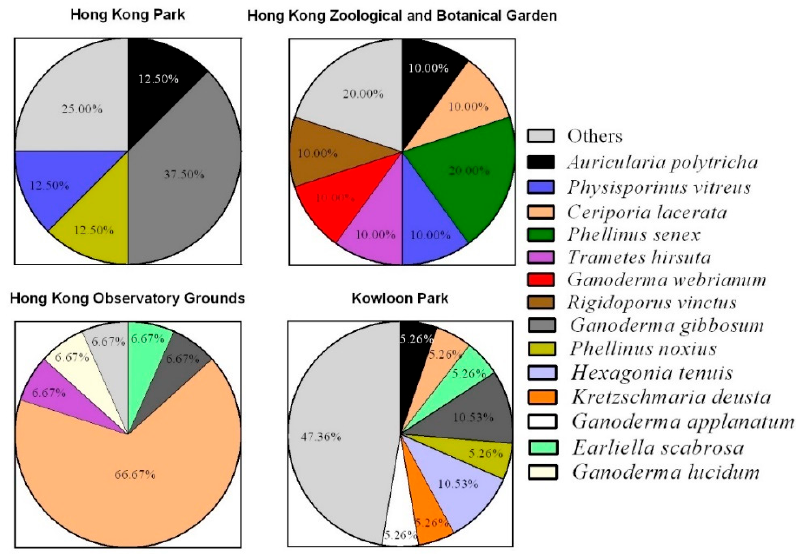
Figure 5. A graph showing the wood-decay fungal species assemblages in each park and the percentage of each fungal species in terms of all the samples collected from each park. Each color represents one significant wood-decay fungus, and non- or less significant wood-decay fungi are categorized as